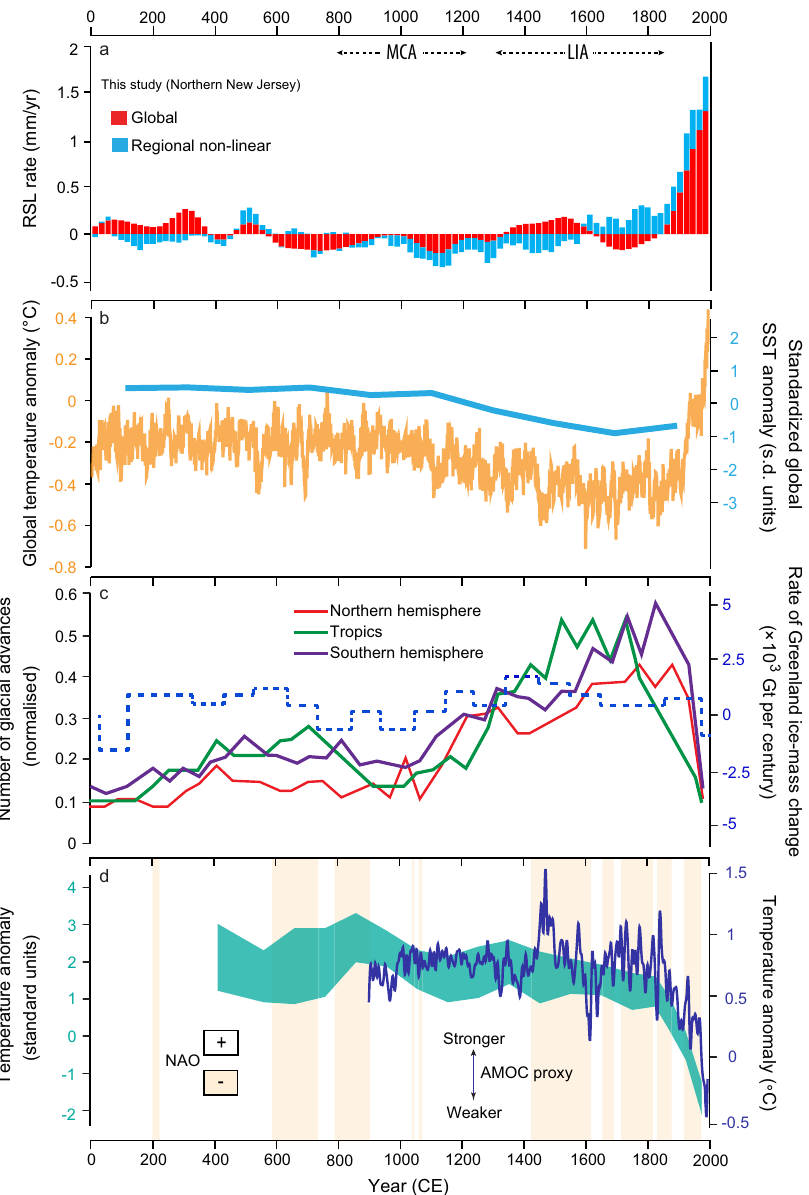
Fig. 5 Sea-level budget compared with climate proxies over the Common Era. a Global and regional nonlinear portion of the sea-level budget for northern New Jersey. RSL relative sea level. b PAGES2k global surface temperature anomaly from Neukom et al. 20 and standardized Ocean2k synthesis of median global sea surface temperature (SST) anomaly from McGregor et al. 68 . c Number of glacial advances by region from Solomina et al. 21 and rate of Greenland ice-mass change from Briner et al. 36 . d Atlantic Meridional Overturning Circulation (AMOC) proxy reconstructions from Rahmstorf et al. 69 (blue) and Thornalley et al. 32 (green) and positive and negative North Atlantic Oscillation (NAO) reconstruction adapted from Baker et al. 30 . Timing of Medieval Climate Anomaly (MCA) and Little Ice Age (LIA) from Neukom et al. 70